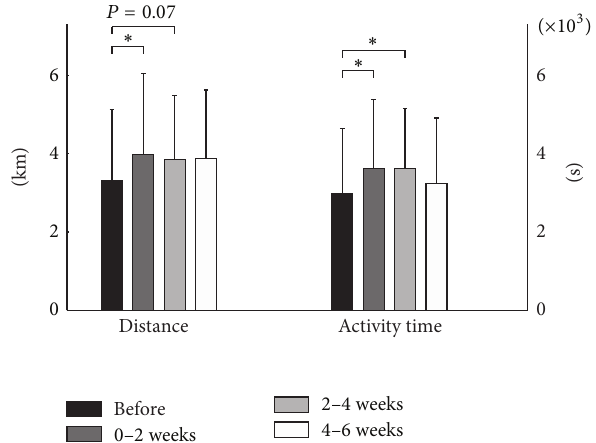
Figure 3: Mean daily distance covered and activity time during the two-week periods from two weeks before the injection to six weeks after the injection. ∗ 𝑃 < 0.05 .